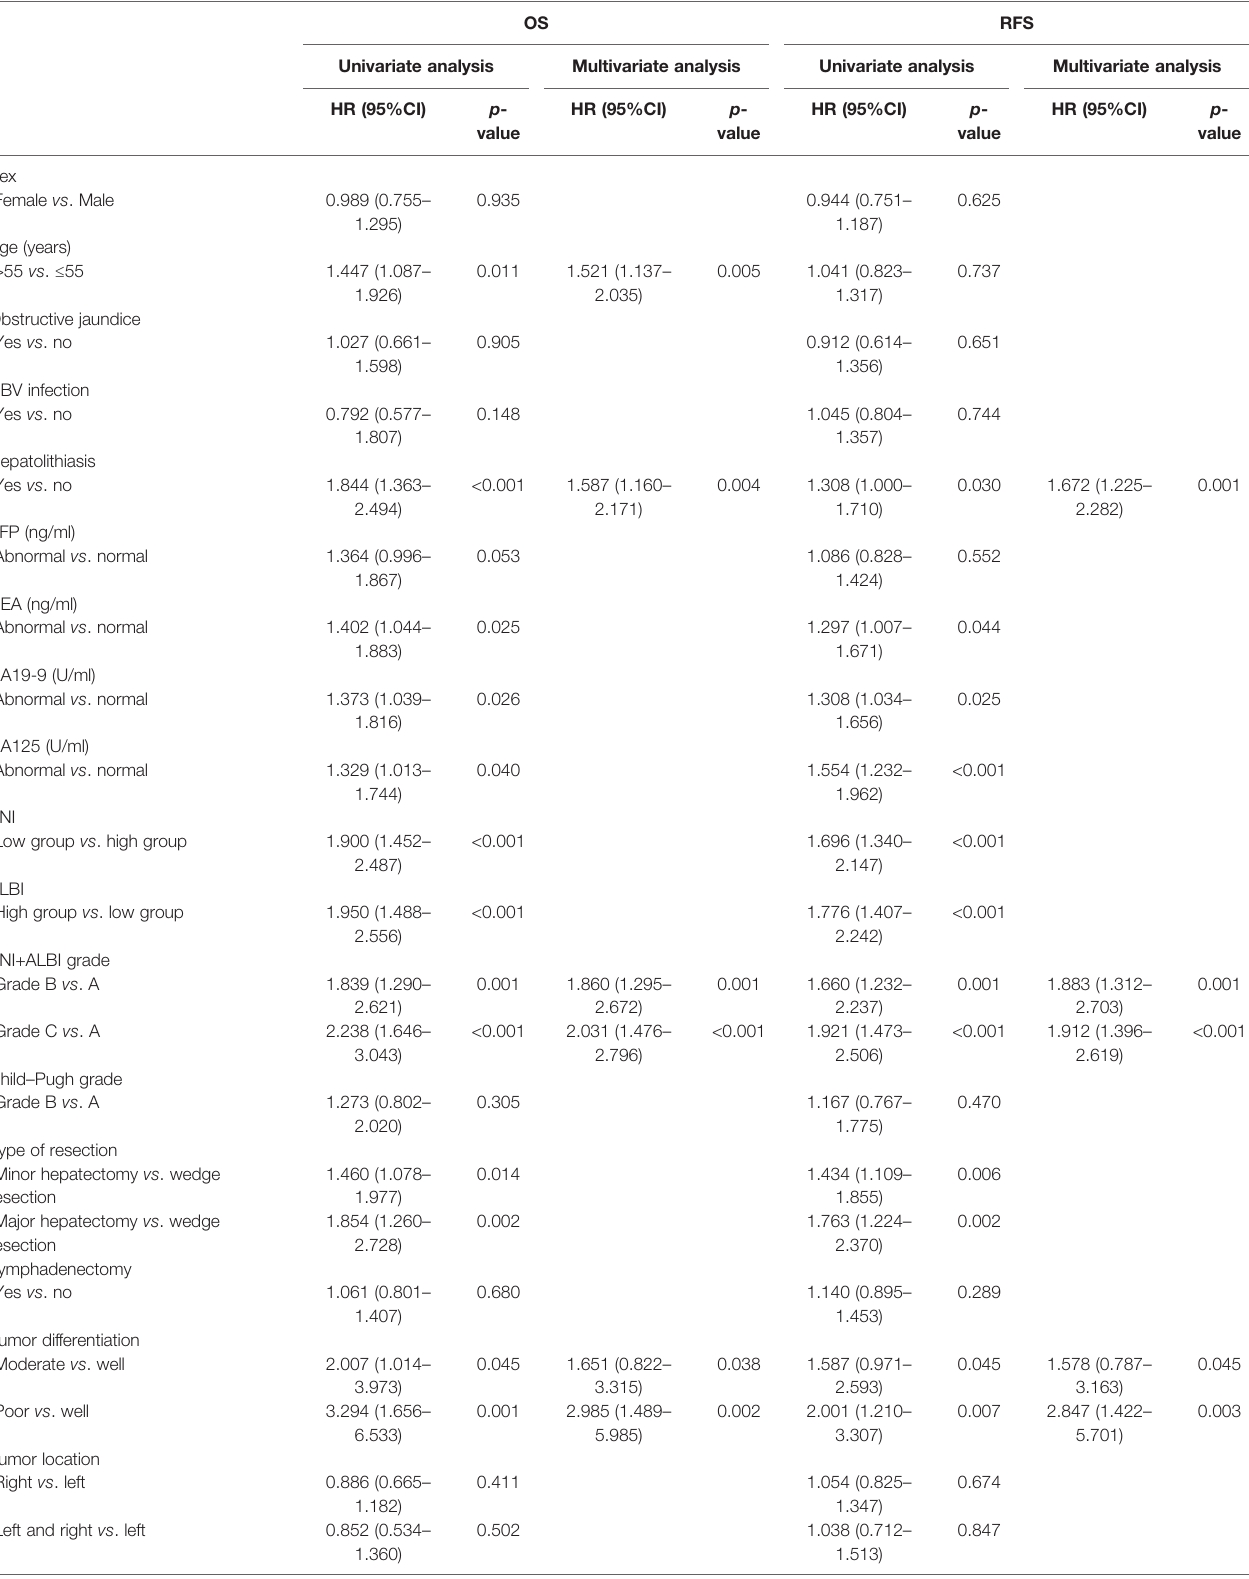
TABLE 1 | Univariate and multivariate analyses of the prognosis for intrahepatic cholangiocarcinoma (ICC) after radical resection. OS RFS Univariate analysis Multivariate